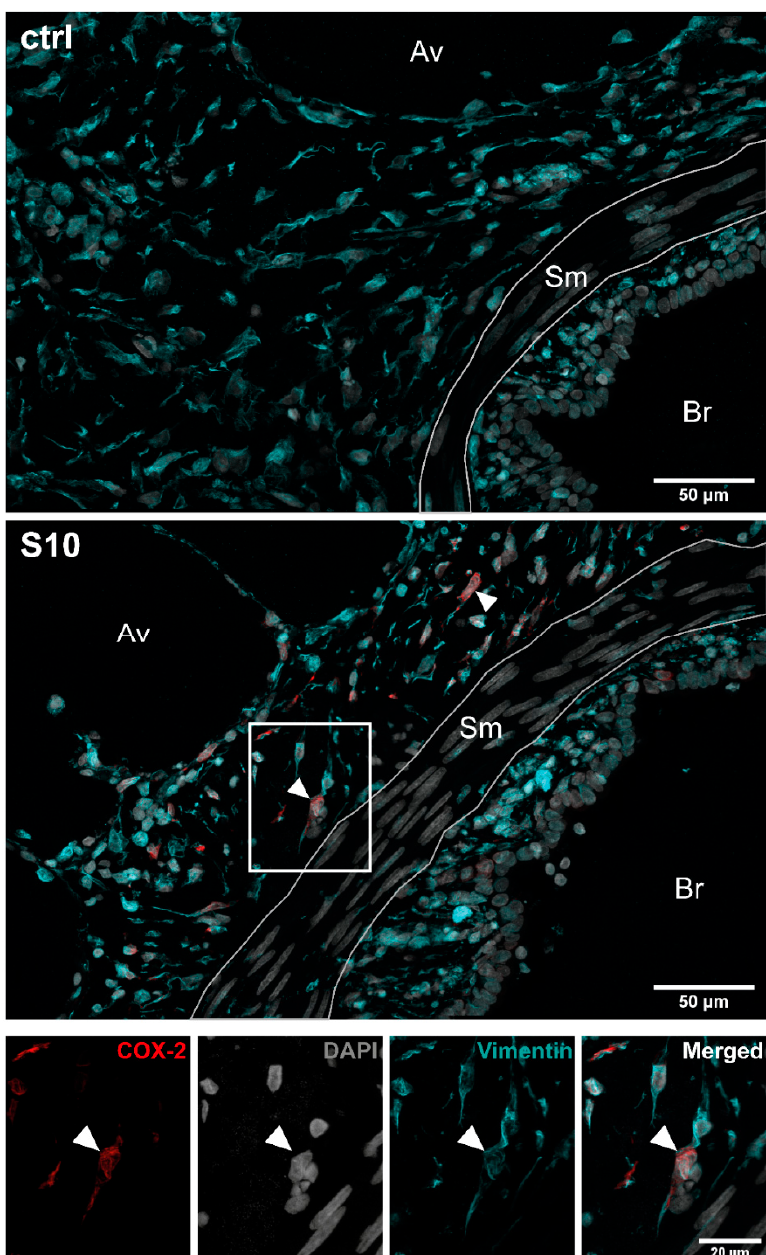
Figure 4. Co-staining of COX-2 and vimentin in S. suis infected PCLS. PCLS were left uninfected (ctrl) or infected with S. suis S10 (S10) for 24 h. After fixation, the tissue was stained for COX-2 (red) and vimentin (cyan). Nuclei were visualised with DAPI (grey). Stained tissue was analysed by confocal microscopy. The boxed region is shown enlarged in the lower panel. The area containing smooth muscle cells (Sm), which are negative for vimentin, is labelled. Closed arrowheads indicate exemplary elongated/spindle shaped cells in the bronchiolar region that show strong vimentin staining and are positive for COX-2. One representative of two independent experiments is shown. Av, alveolar tissue; Br, bronchioles; Sm, smooth muscle cells.